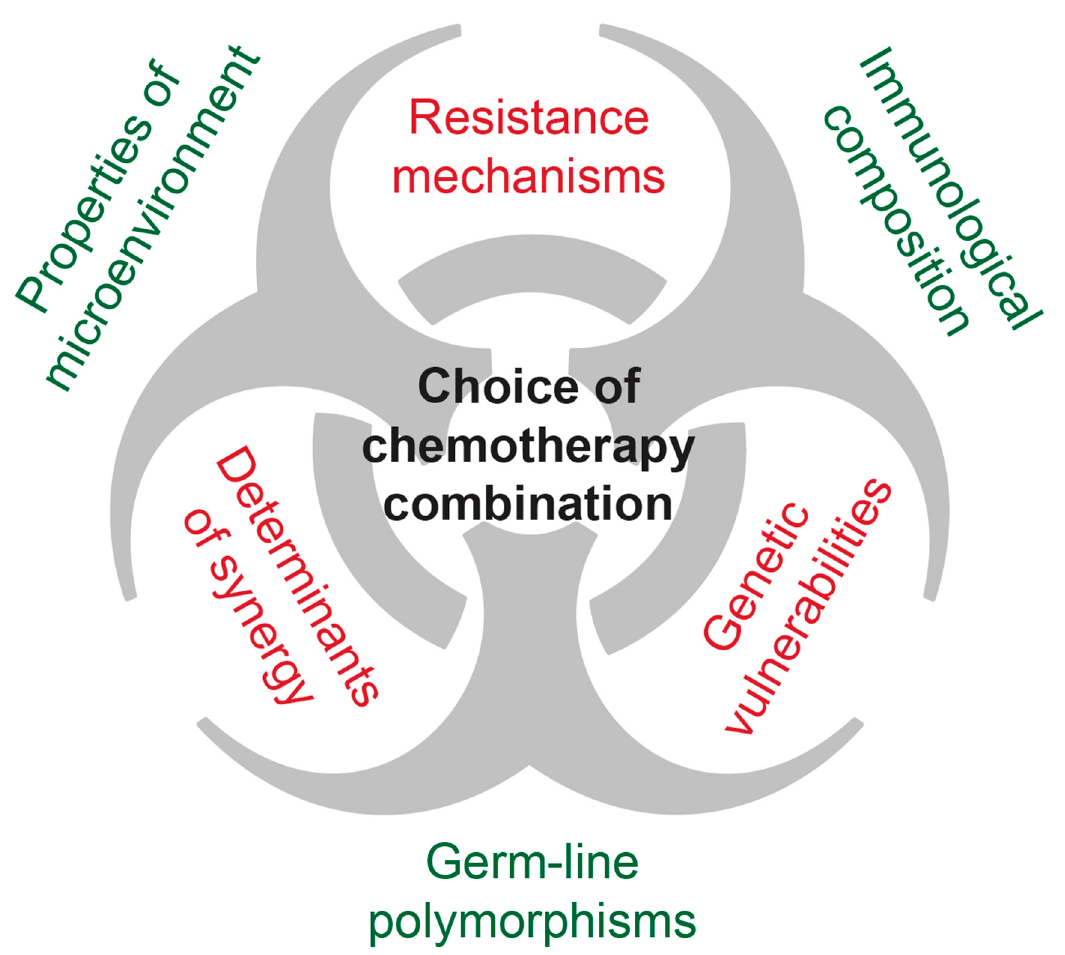
Figure 3. Schematic overview of somatic (red) and host (green) factors, which interact the efficacy of combination chemotherapy in osteosarcoma. Host factors: properties of microenvironment: vascularization, osteolytic activity, and inflammation are examples that modulate efficacy of chemotherapy. Immunological composition: the degree of immune cell infiltration, the type (e.g., tumour-associated macrophages and T-cells), and subtype (e.g., M2-polarization and CD8-positivity) as well as degree of immune cell exhaustion (e.g., expression of programmed death ligand-1 (PD-1)) correlate with treatment outcomes. Germ-line polymorphisms: pharmacokinetics of drugs like methotrexate modulate the effective drug exposure of tumour cells. Somatic factors: resistance mechanisms—upregulation and somatic mutations in, e.g., efflux pumps or catabolizing enzymes can detoxify osteosarcoma cells from cytotoxic drugs. Genetic vulnerabilities: activating mutations in signalling pathways can render osteosarcoma susceptible for small molecule inhibitors. Furthermore, while somatic defects in, e.g., the DNA damage response (“BRCAness”) might confer resistance to conventional cytotoxic agents, this also renders tumour cells vulnerable to synthetic lethality through poly (ADP-ribose) polymerase 1 (PARP) inhibitors. Determinants of synergy: currently unknown somatic factors that determine the extent of synergy, e.g., of cisplatin and doxorubicin, might help to predict responses to chemotherapy combinations. A rational choice of individualized combination chemotherapy would need to take these factors into account.